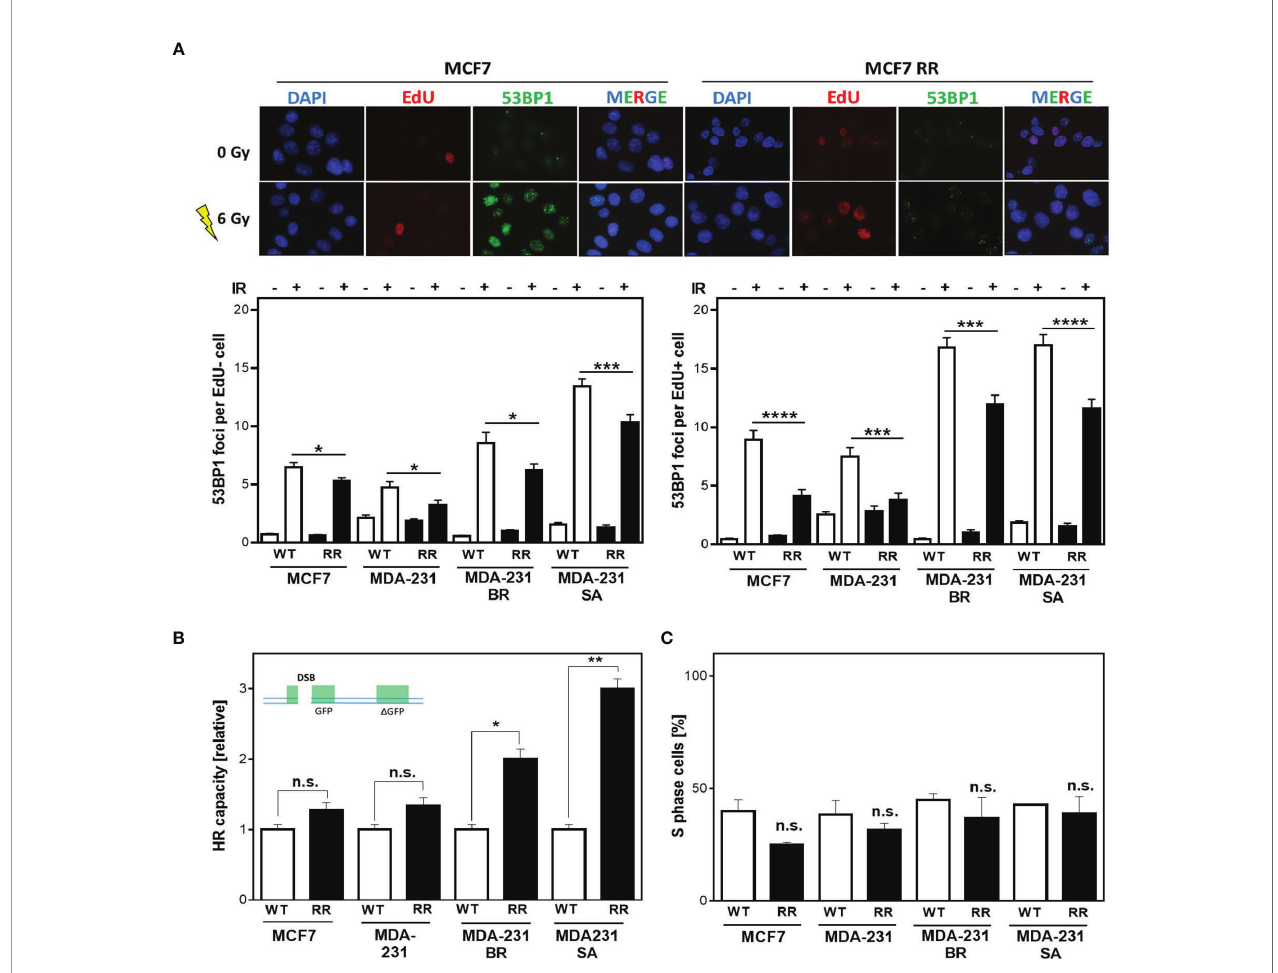
FIGURE 2 | Radiation resistance of BCSC is mediated in S phase. (A) 53BP1 foci (green) in non-S phase (EdU-, bottom left) and S phase (EdU+, bottom right) cells after irradiation. Cells were irradiated with 6 Gy after pulse labeling with 10 µM EdU for 20 min. Immunostaining was per-formed 24h after treatment with a speci fi c antibody against 53BP1 and a fl uorescent second anti-body. Nuclei were stained with DAPI, replicating cells were discriminated by incorporated EdU stained with the “ click-it ” -reaction. Foci were quanti fi ed with Image J Software for EdU+ and EdU- cells (n = 100). (B) HR repair of DSB. Cells were transiently transfected with the linearized DR-GFP plasmid for 24h. The number of GFP-expressing cells was analyzed by FACS and HR capacity of the radioresistant clones was normalized to the absolute HR capacity of the parental cell lines. (C) Percentage of S Phase cells. Exponentially growing cells were pulse-labeled with 10 µM EdU for 20 minutes, fi xed and EdU stained with the “ click-it ” reaction. Nuclei were counterstained with DAPI. The number of EdU+ and EdU- cells was counted (n=100). Shown are means of three independent experiments ± SEM. Asterisks (*) represents signi fi cant differences (n.s., not signi fi cant; *p < 0.05; **p < 0.01; ***p < 0.001, ****p < 0.0001, Student ’ s